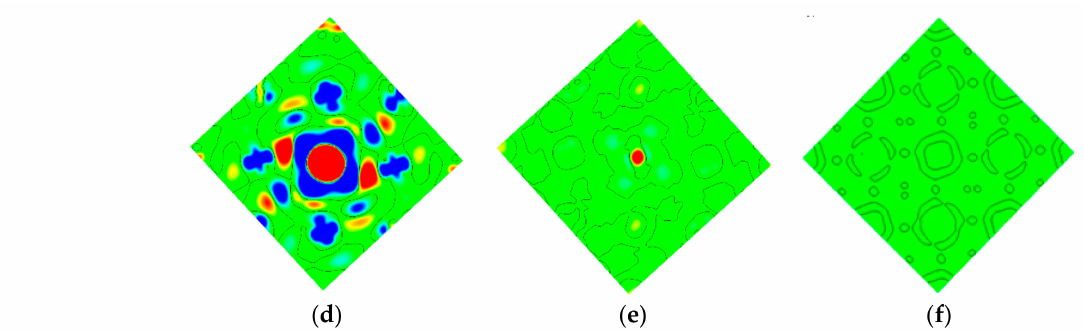
Figure 5. Spin density distributions for different doped systems. ( a – f ) correspond to Cr-, Mn-, Fe-, Co-, Ni- doped and pristine PdSe 2 , respectively. The 2D planes are determined by two Pd atoms and the dopants for the doped system, three Pd atoms for pristine PdSe 2